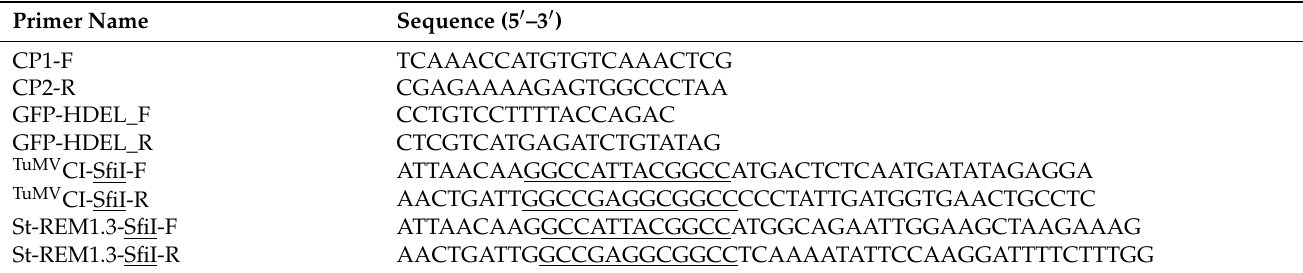
Table 1. List of primers used in this